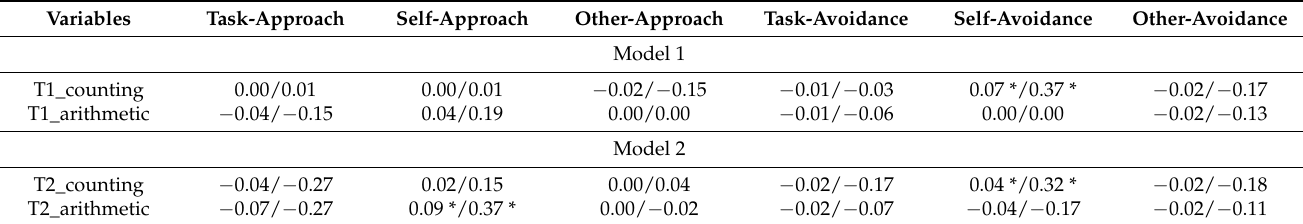
Table 2. Path coefficients of concurrent effect and predictive effect